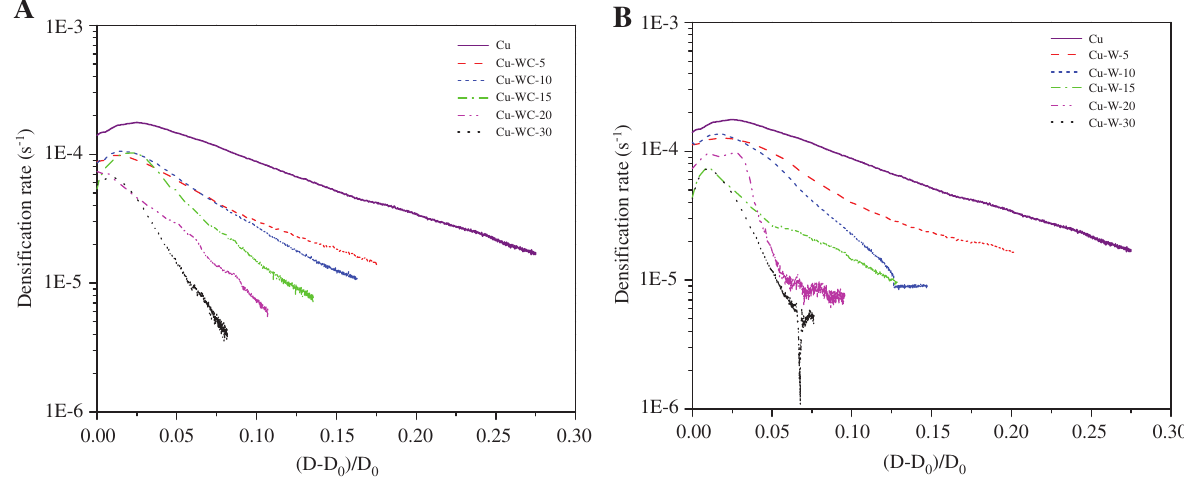
Figure 4: Densification rate as a function of densification during the sintering plateau: (A) Cu-WC and (B)